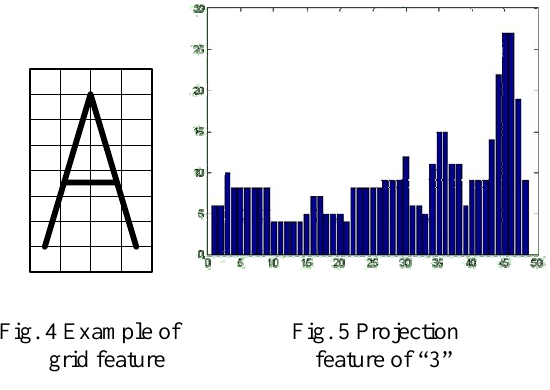
Fig. 4 Example of Fig. 5